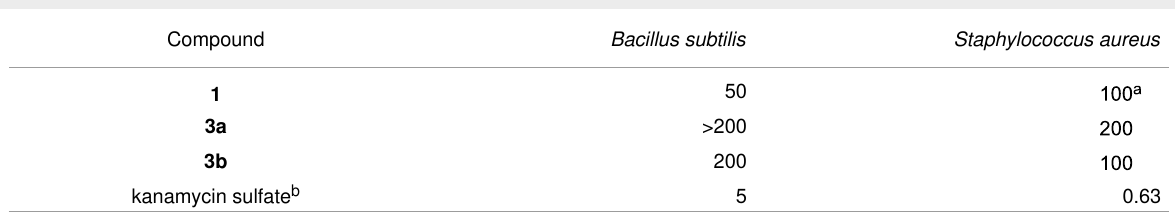
Table 2: Antimicrobial activity of nostochopcerol ( 1 ) and synthetic